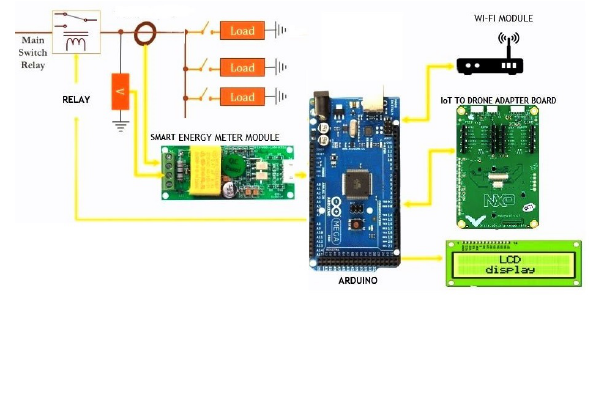
Fig. 4. Block diagram of the proposed system for IoT environment with Wi-Fi & Drone